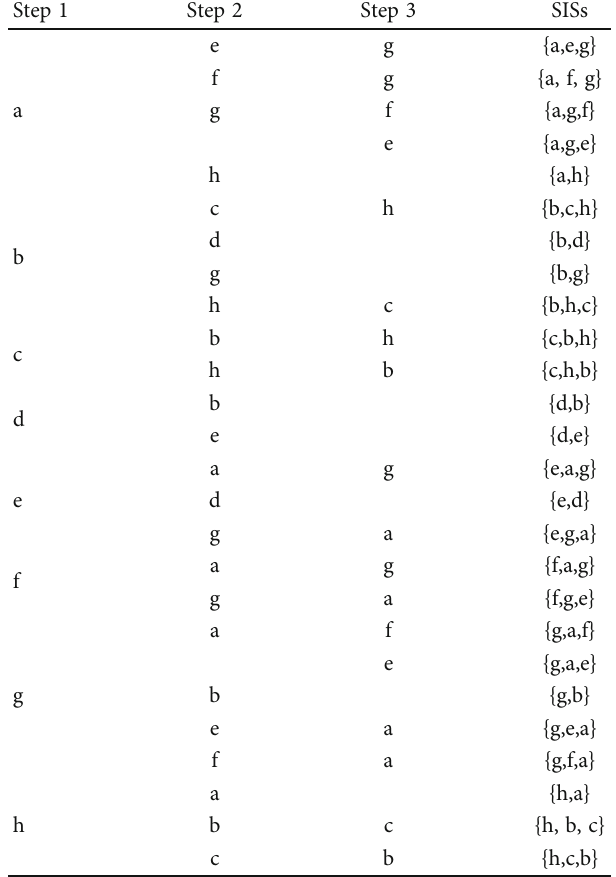
Table 11: Calculations for fi nding maximal SISs in the IVIFG of Figure